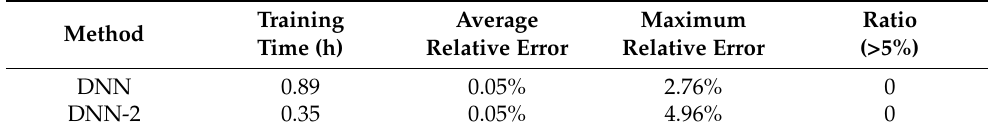
Table 7. The prediction results of two methods using DNN for total capacitance.